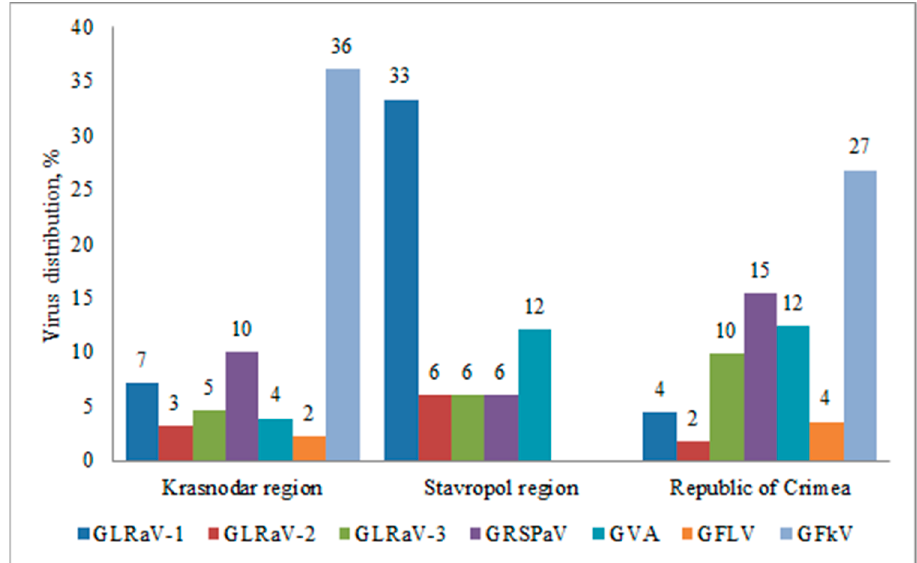
Figure 3. Distribution of grapevine viruses in various regions of the Russian Federation (percent- age of the number of samples collected in the region). of the number of samples collected in the